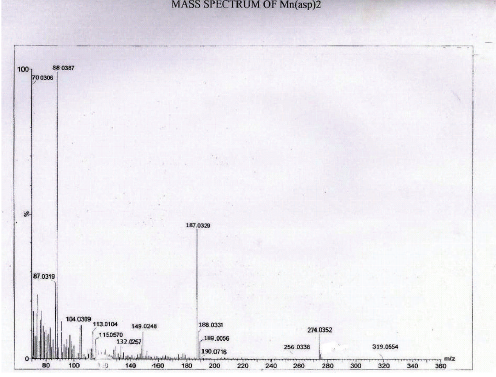
Figure 6: Mass spectrum of Mn(asp) 2 .